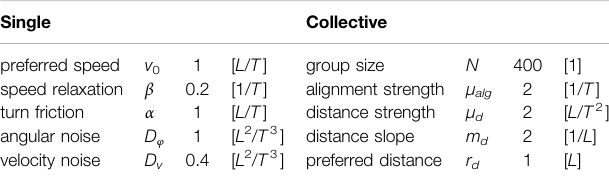
TABLE 2 | Default model parameters. If fi gures represent simulation with a different set of parameters, it is explicitly stated in the caption. The units are given in general length L and time T units.